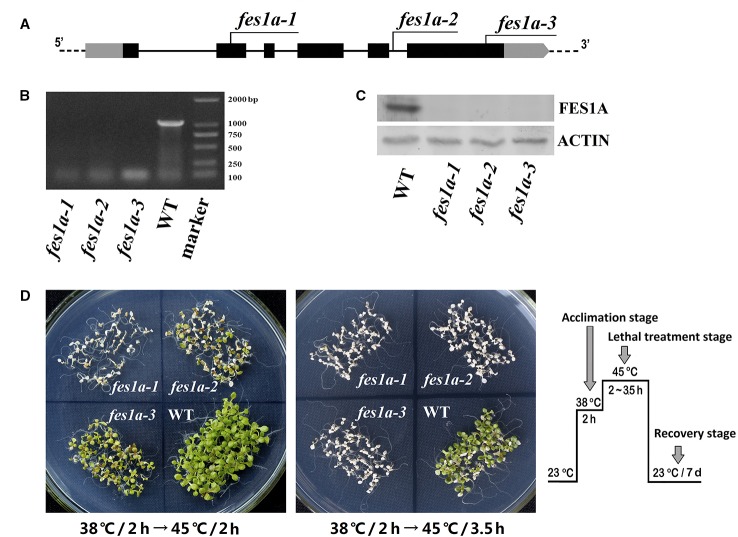
Differences in thermotolerance of the three fes1a mutants. (A) A diagram showing T-DNA insertions in three examined fes1a mutants. Exons are black boxes, untranslated coding regions are grey boxes, and introns are lines. RT-PCR (B) and western blots (C) exhibiting transcription and translation of FES1A, respectively. Plants were treated at 38 °C for 2 h before total RNA and protein extraction. (D) Evaluation the thermotolerance of fes1a mutants. A temperature-increasing regime for thermotolerance evaluation is schematically shown on the right. Ten-day-old plants were first acclimated at 38 °C for 2 h and then subjected to lethal heat treatment at 45 °C for 2~3.5 h as indicated in the center of each petri dish. After heat stress, plants were transferred to a growth chamber under normal growth conditions for recovery and were photographed after seven days of recovery.